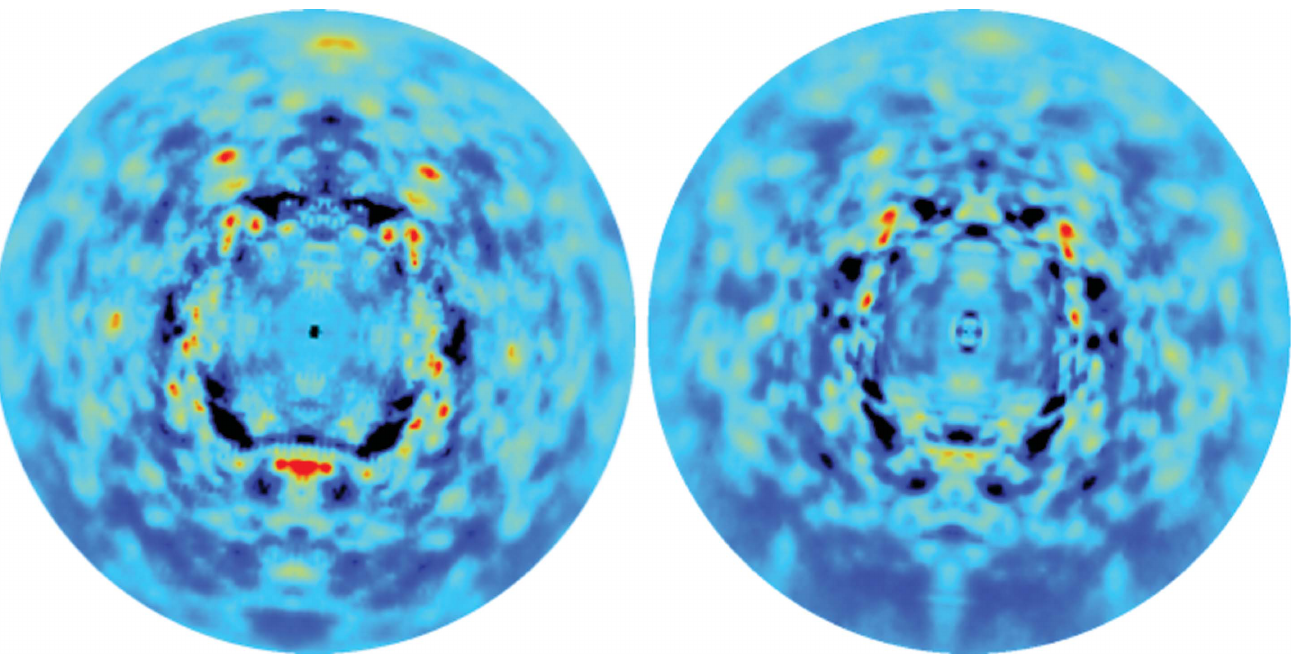
Figure 3 Comparison of simulated diffraction images calculated from the simulated (left panels) and experimental (right panels) three-dimensional diffuse intensities. The crystal orientation corresponds to the first diffraction image in the rotation series. The display is truncated at 1.6 A˚ . The mean pixel value at each scattering vector was subtracted, and then the minimum value in the image was subtracted, prior to visualization. The images were displayed using the rainbow color map in Adxv (Arvai, 2012), with a pixel value range arbitrarily chosen to highlight the similarities.